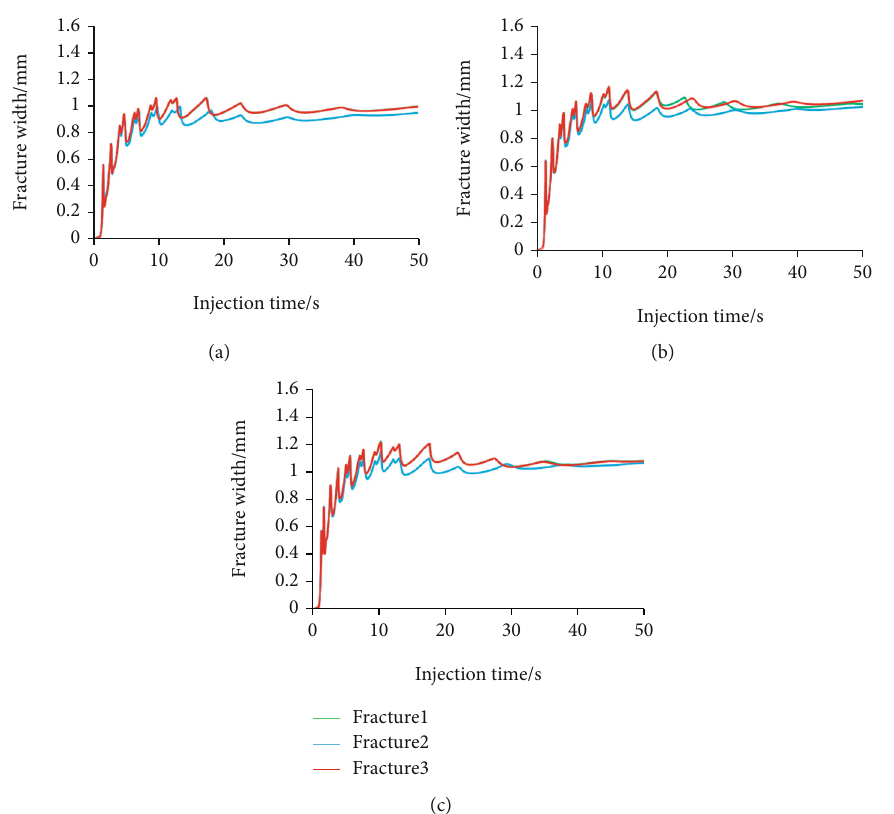
Figure 19: The maximum fracture width of each cluster as a function of time for di ff erent fl ow rates: (a) case 5 (6 m 3 /min); (b) case 6 (8 m 3 /min); (c) case 7 (10 m 3